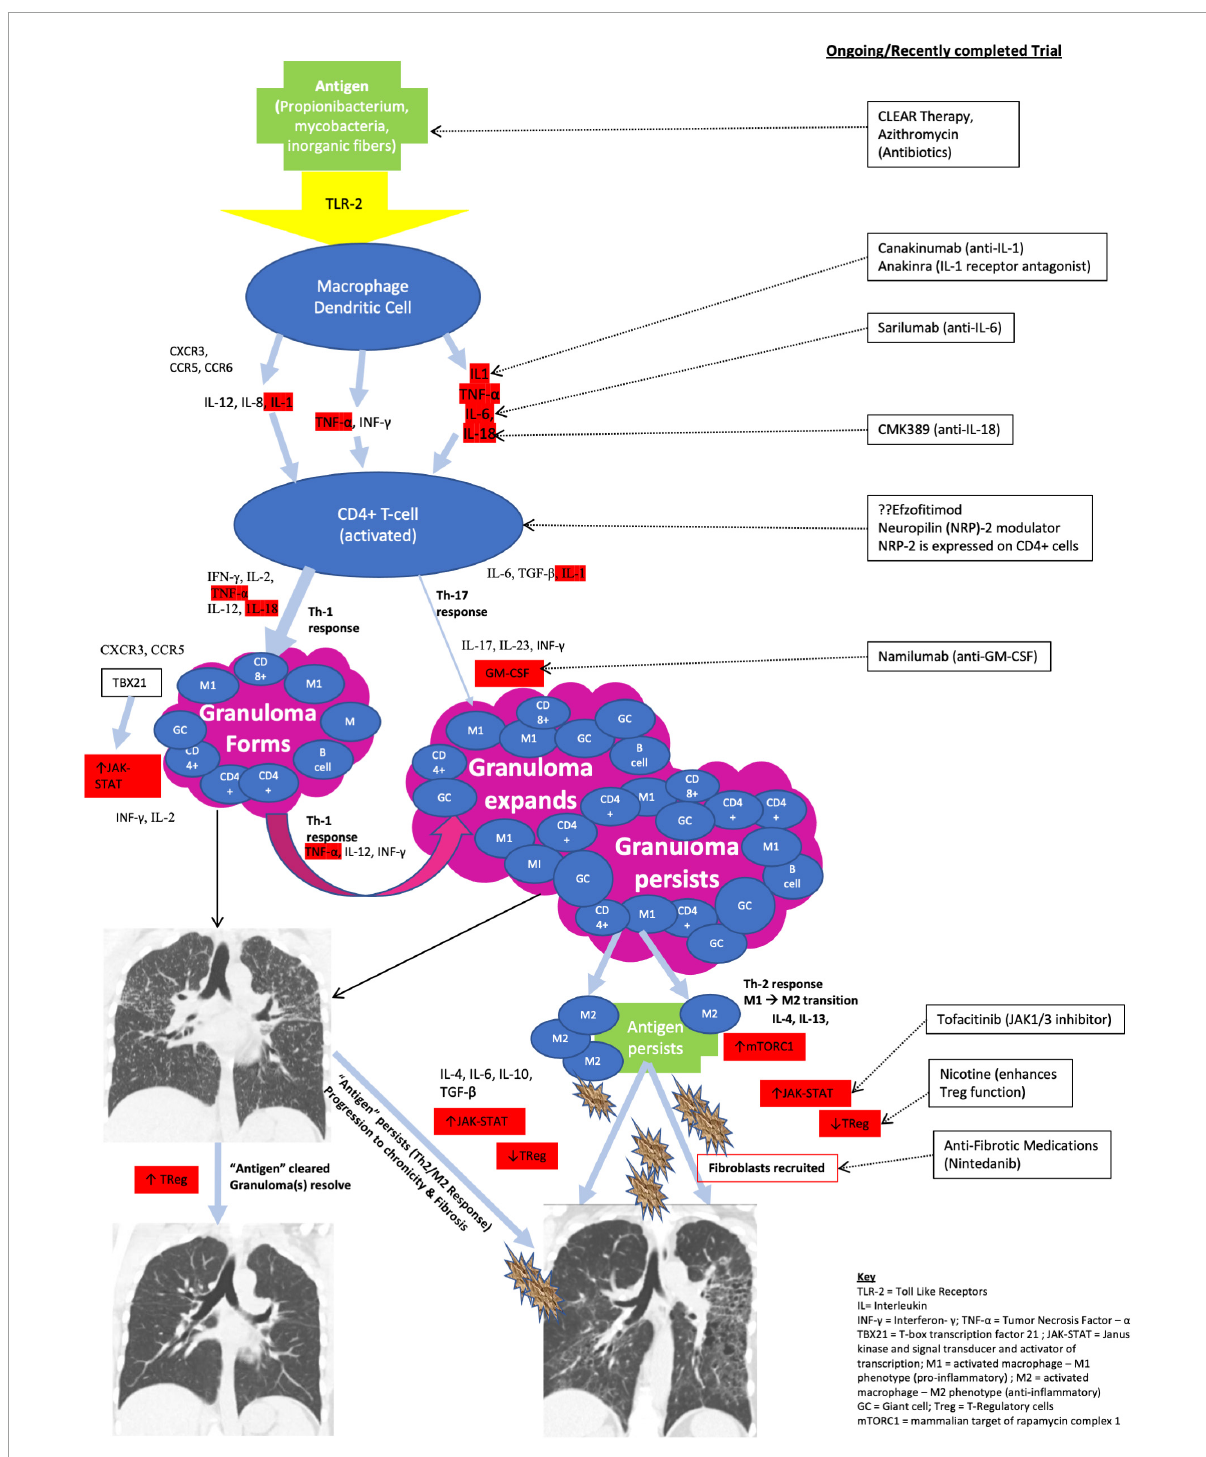
FIGURE3 Immunologic cascade resulting in sarcoid granuloma formation.